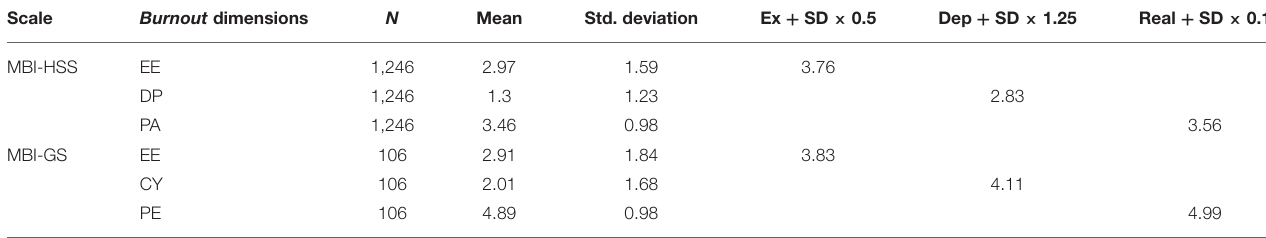
TABLE 2 | MBI-HSS and MBI-GS scores to determine burnout. Scale